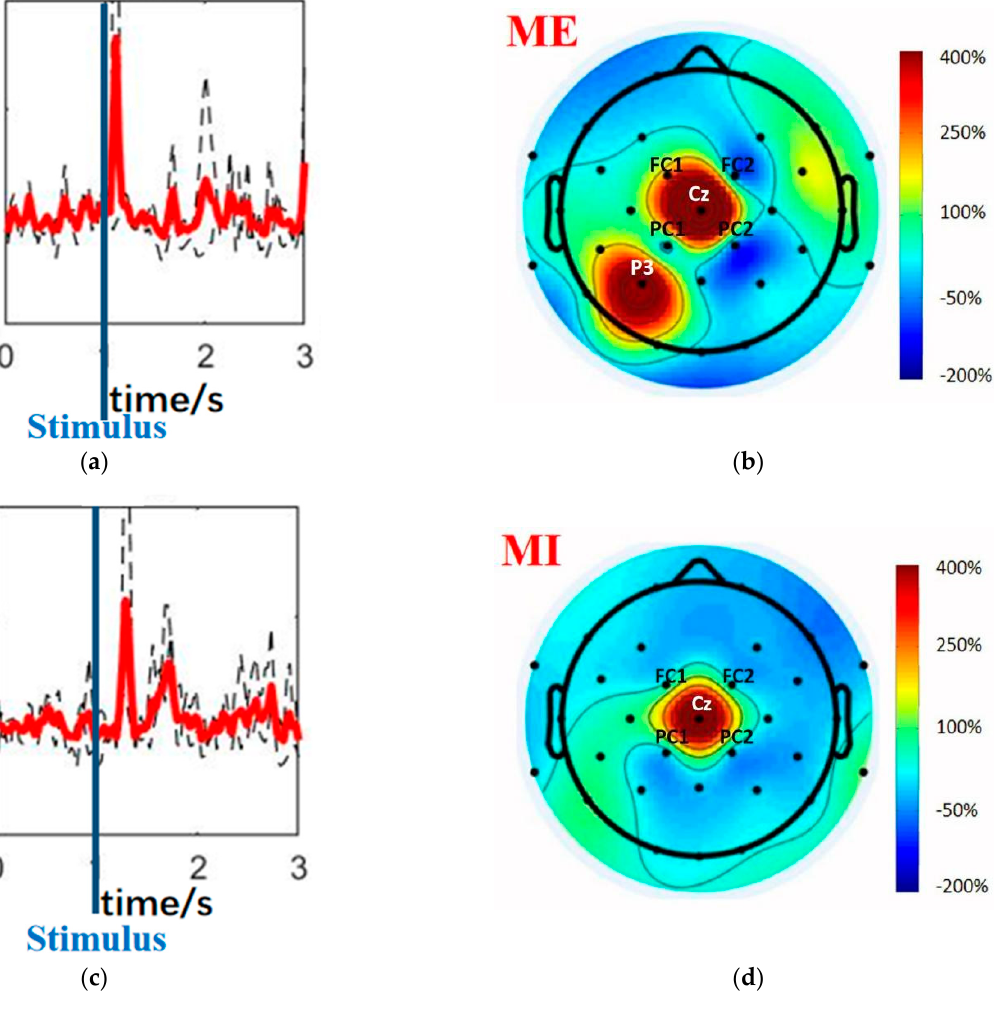
five different individuals while bold red lines delineating the average time course across these subjects. Beta rebounds are represented as peaks in these lines. “Stimulus” marks the time when subjects hear the auditory instructions. Compared with ME, the beta re- bounds of MI have smaller amplitude, appear later after stimulus, and last longer. In the spatial domain, ME and MI have different topographic distributions. Figure 5b (ME) and Figure 5d (MI) demonstrate it with topo-plots (topographic maps of EEG fields in a circu- lar 2D view looking down at the top of the head) depicting ERD/ERS distribution. These